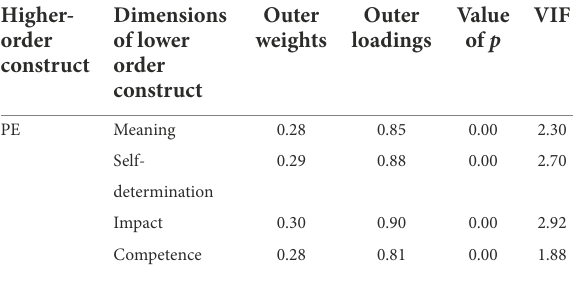
TABLE 3 Measurement properties of formative construct.